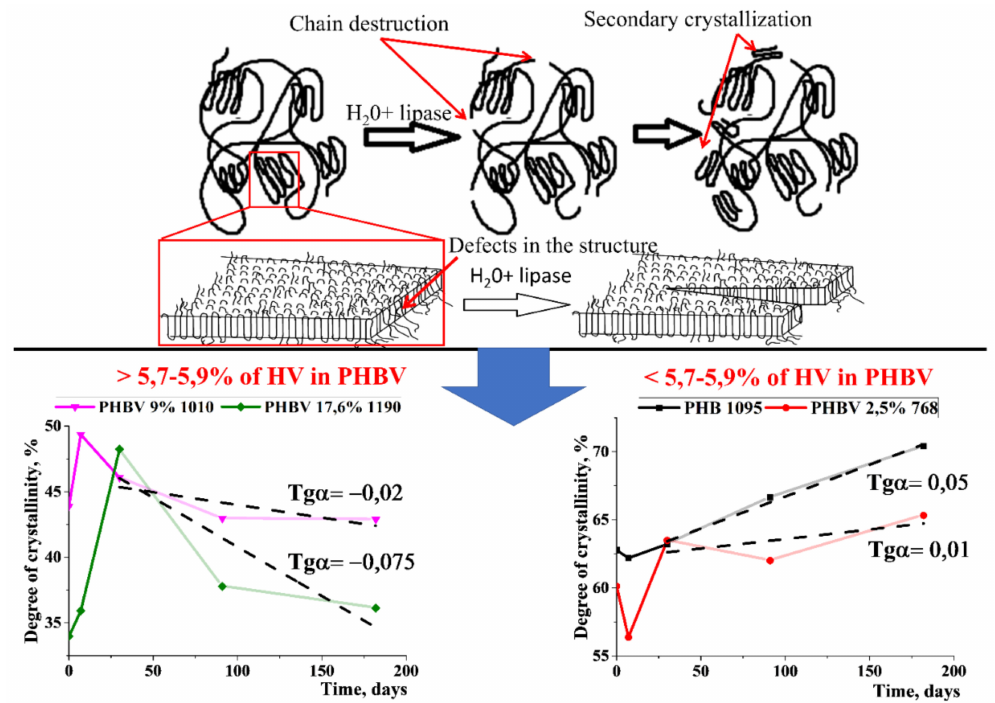
Figure 9. The model of in vitro degradation of PHB and PHBV. It was found that in the process of degradation, the degree of crystallinity increases if the content of 3-HV in the copolymer is less than 5.9% and decreases if it is more than